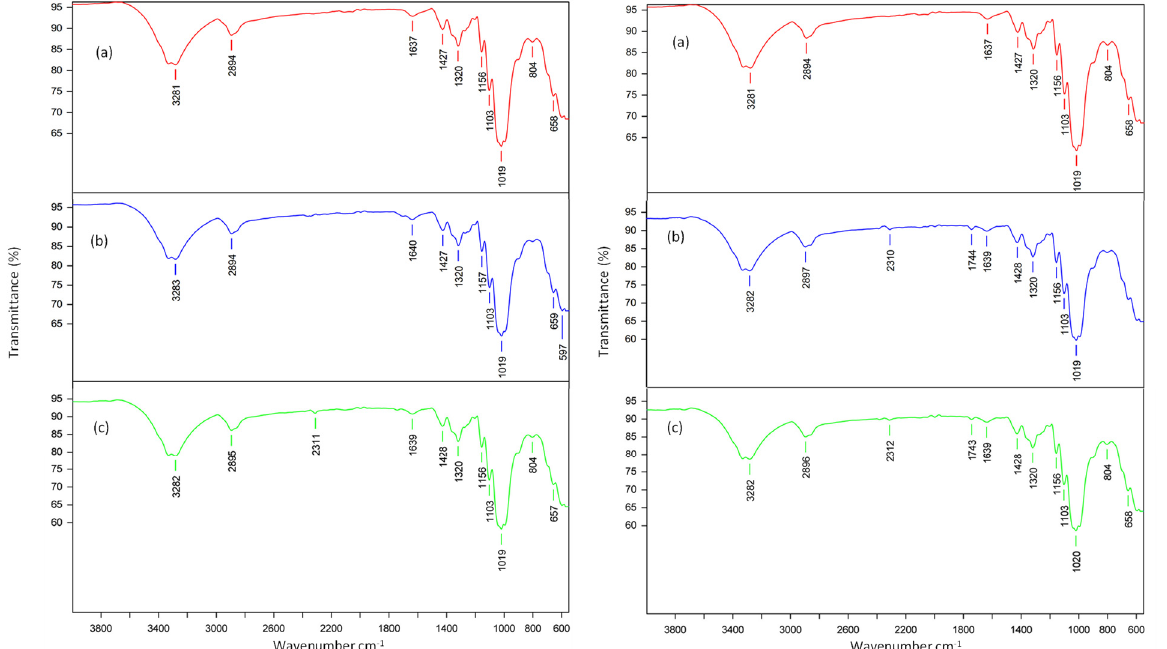
Figure 9. FTIR for Moringa oleifera and Aegle marmelos 20 gsm fabrics.